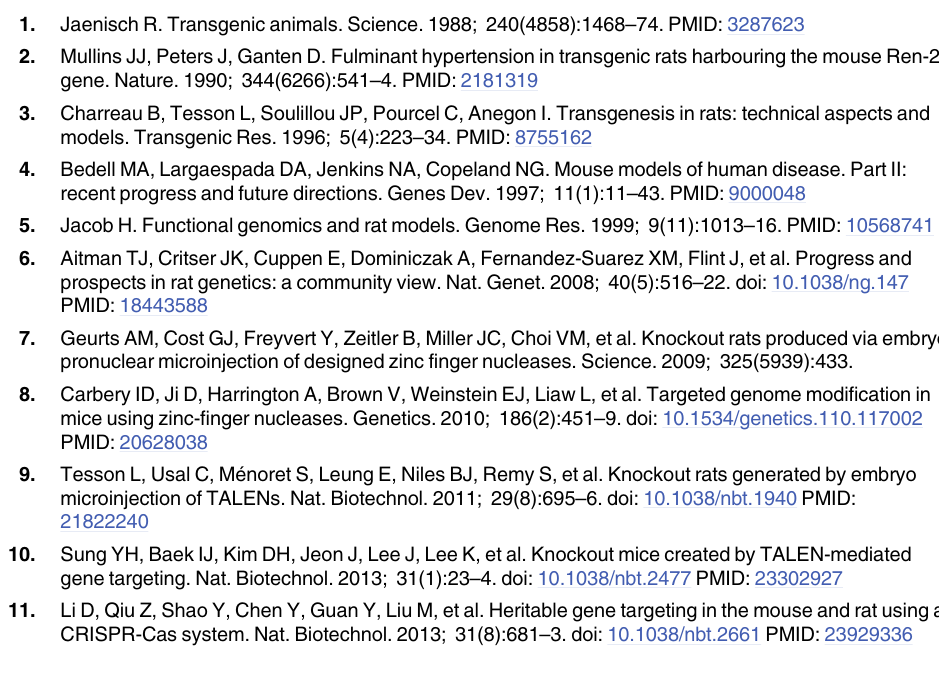
S1 Fig. Sequence of the mouse (A) and rat (B) Il2rg locus. Red capital letters indicate the position of the one base exchange. S1 Table. Sequences of single-stranded donor oligonucleotides (ssODNs) and primers for the Il2rg locus. S2 Table. Germ-line transmission in rat offspring with an edited Il2rg locus derived from the technique for animal knockout system by the electroporation (TAKE)